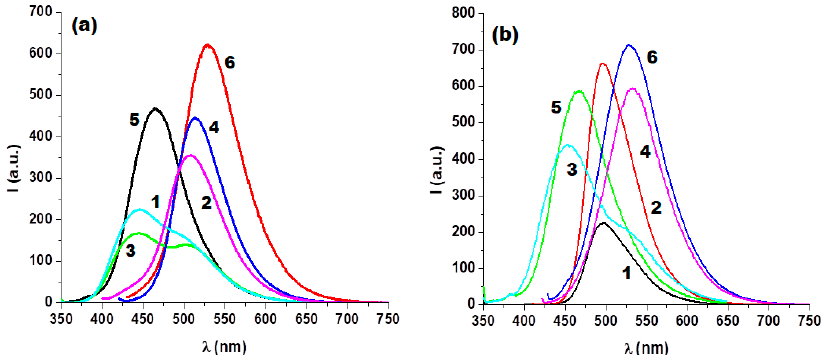
Figure 3. Fluorescence spectra of naphthalimide derivatives in different solvents as a function of excitation wavelength for ( a ) 7 (1—dioxane (Dx) (342 nm); 2—dioxane (Dx) (398 nm); 3—CHCl 3